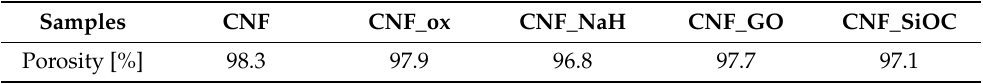
Table 1. Total porosity of CNF before and after